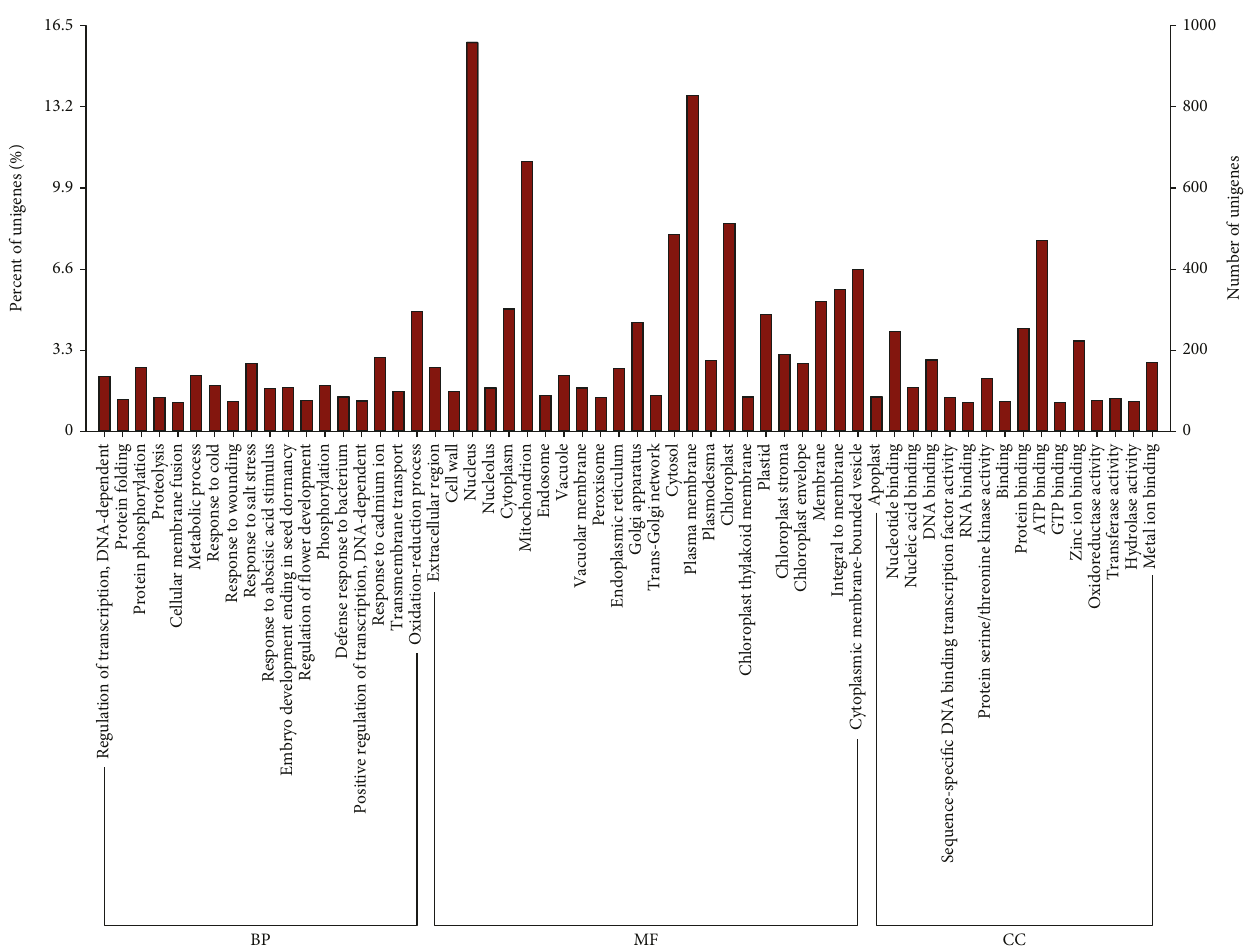
Figure 3: Gene ontology classi fi cations of 6130 orthologous unigenes. The results are clustered in the three main categories as biological process (BP), cellular component (CC), and molecular function